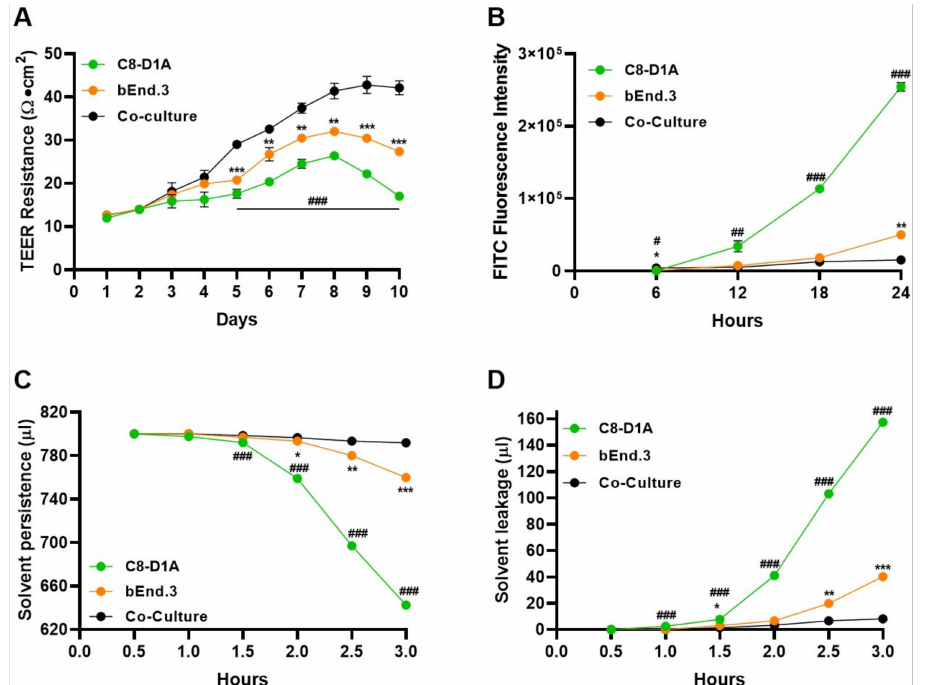
Figure 2. The co-culture BBB model showed efficient barrier properties. Assays were used to analyze the barrier property of bEnd.3 and C8-D1A cells seeded individually or grown in co-culture conditions. ( A ) Transendothelial electrical resistance (TEER) analysis using chopstick electrodes to record resistance across the transwell membrane grown with bEnd.3, C8-D1A cells or co-cultured. ( B ) Fluorescein isothiocyanate (FITC) dextran permeability assay was used to analyze the barrier capacity of the in vitro BBB model. ( C ) Solvent persistence and ( D ) solvent leakage tests were used to measure how long bEnd.3, C8-D1A, and co-cultured cells can hold the media on the apical side of the transwell. All data had a sample size of three ( n = 3) and three experimental repeats. Data are presented as mean ± SEM. The mono-culture models were compared to the co-culture models (* bEnd.3, # C8-D1A). p < 0.05 was considered to be statistically significant. * ;# p < 0.05, ** ;## p ≤ 0.01 and *** ;### p ≤